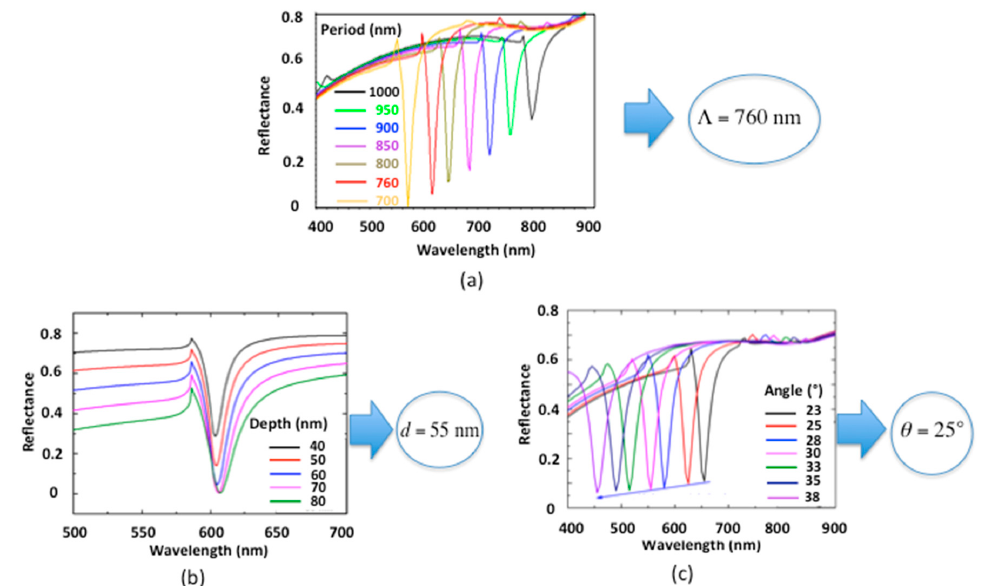
Figure 3. Simulated TM reflection spectra in acetone for: ( a ) Grating periods 700 nm < Λ < 1000 nm (aluminum thickness e = 50 nm, grating depth d = 55 nm, incidence angle θ = 25 ◦ ); ( b ) Di ff erent grating depths d ( Λ = 760 nm, e = 50 nm, θ = 25 ◦ ); ( c ) Di ff erent incidence angles θ ( Λ = 760 nm, e = 50 nm, d = 55